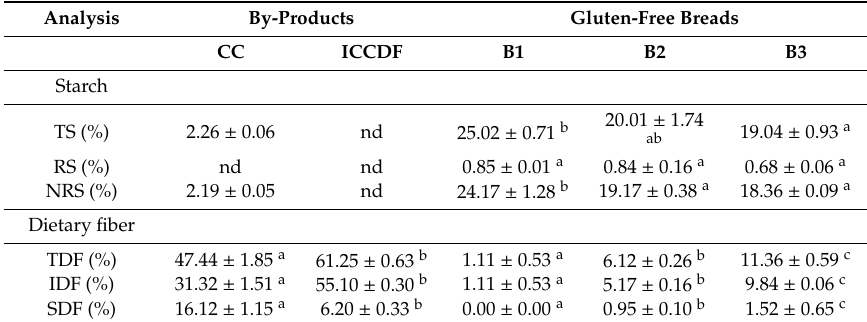
Table 1. Nutritional analysis of co ff ee cascara (CC), isolated dietary fiber from co ff ee cascara (ICCDF) and of gluten-free breads Analysis By-Products Gluten-Free